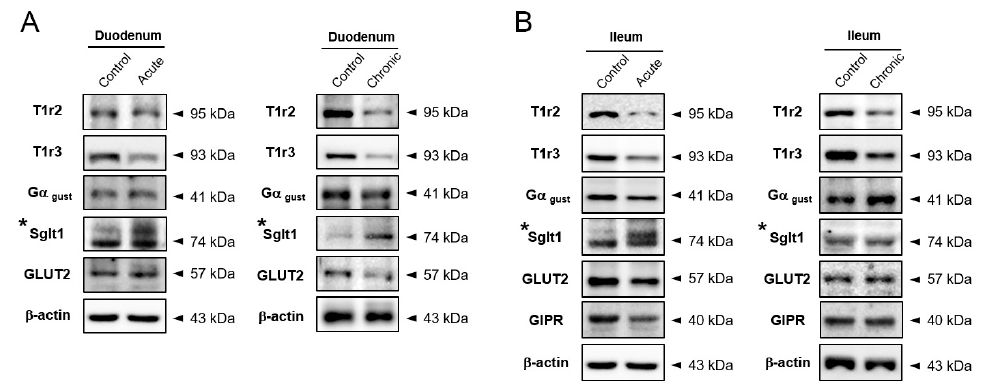
Figure 3. Na + -glucose co-transporter Sglt1 was increased in GI-inflamed mice. The protein expression levels of glucose-sensing receptors including subunits of sweet taste receptor, Sglt1, and GLUT2 in duodenum ( A ) and ileum tissue ( B ) of GI-inflamed mice.